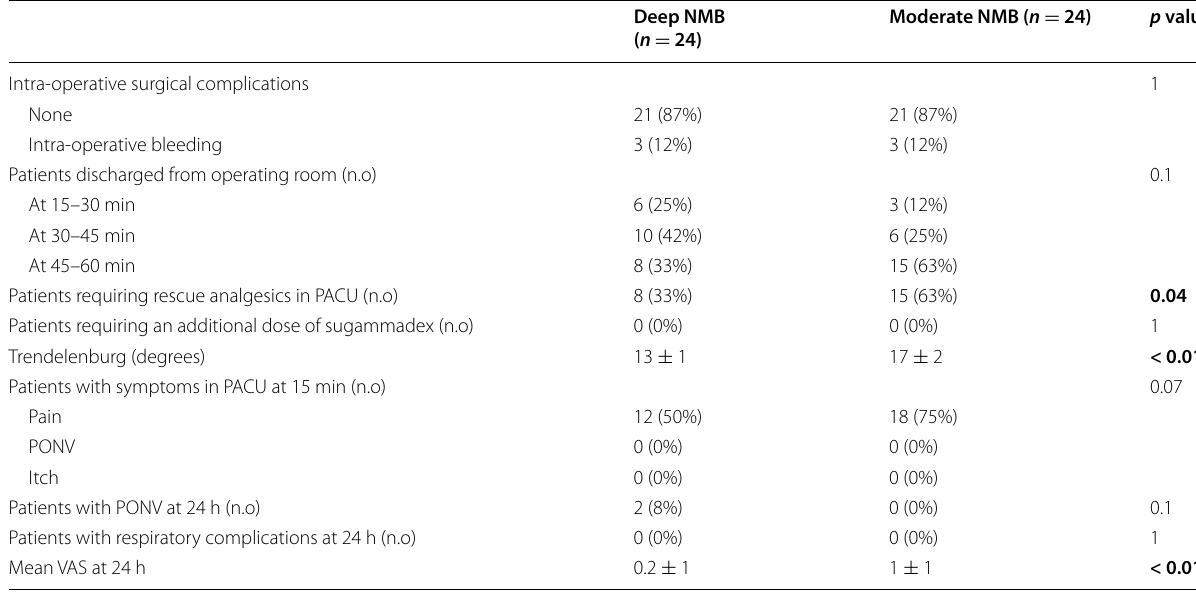
Values are mean, standard deviation (SD) or number of patients (proportion, %) n.o number, NMB neuromuscular block, PACU post-anesthesia care unit, PONV post-operative nausea and vomiting, VAS visual analogue scale for pain Boldface data, statistically significant *not predictable,